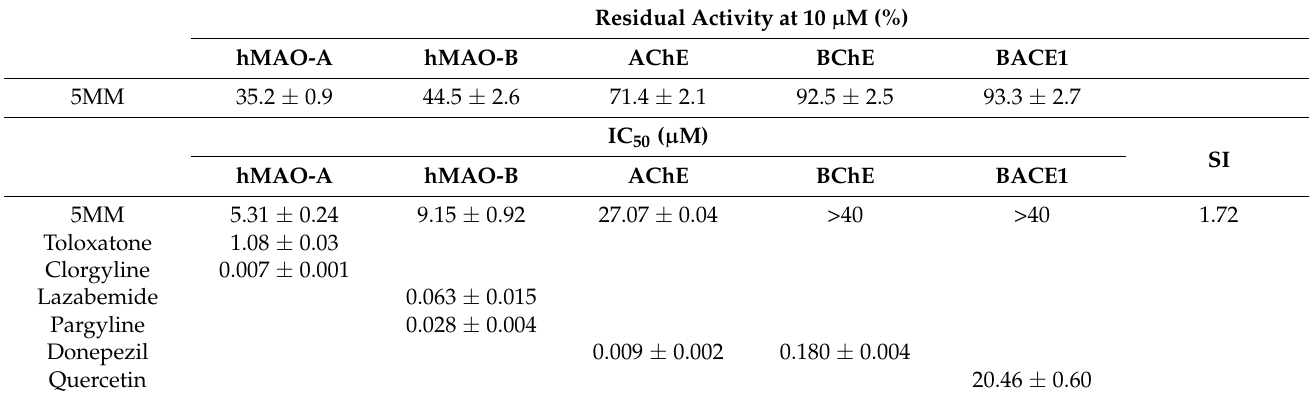
The inhibitory activities of 5MM on hMAO-A, hMAO-B, AChE, BChE, and BACE1 were analyzed at 10 µ M concentration. Compound 5MM exhibited inhibitory activity against hMAO-A and -B, with 35.2% and 44.5% residual activities, respectively (Table 2). 5MM had an IC 50 value of 5.31 µ M for hMAO-A, with an effective potency for hMAO-B (IC 50 = 9.15 µ M), and the selective index (SI) was 1.72 for hMAO-A over hMAO-B (Table 2). In addition, 5MM moderately inhibited AChE (IC 50 = 27.07 µ M) but very weakly inhibited BChE and BACE1 (Table 2). Table 2. Inhibitory activities against hMAOs, ChEs, and BACE1 by compound 5MM. Residual Activity at 10 µ M Table 2. Inhibitory activities against hMAOs, ChEs, and BACE1 by compound 5MM.